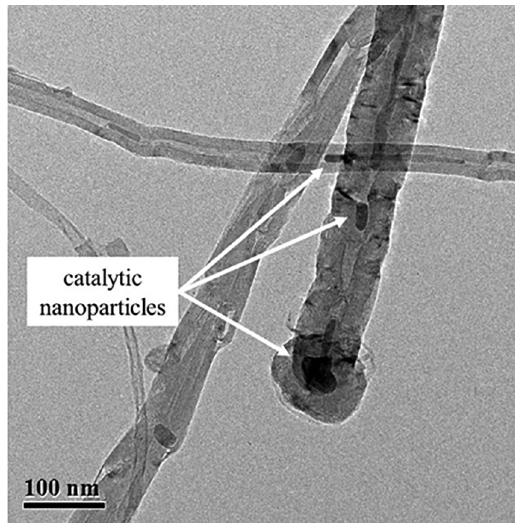
Figure 4: TEM image of CNTs grown on a Zirconia substrate. a nonlinear dependence on the applied optical field. In this way, third order nonlinear optical effects emerge as a part of the atomic response of the media that cubically depend on the strength of the applied optical field. The optical response can be expressed as a power series by the relation between the polarization, P, and electrical field, E, as: 27